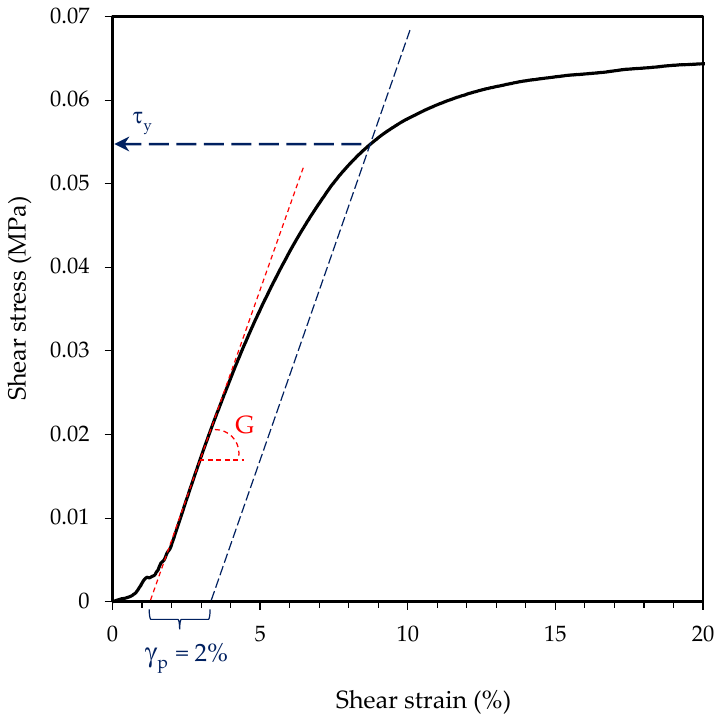
Figure 1. Experimental curve stress vs. strain, registered from dynamic shear testing, with indications of shear modulus (G) and yield stress (τ y ) determination.